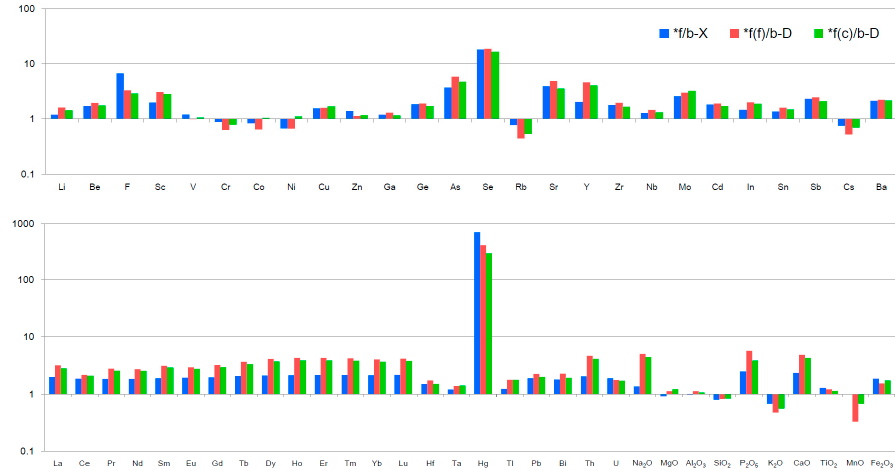
Figure 8. Average ratios of element concentrations in the fly ash vs. bottom ash from the Xilaifeng (X) and Damo (D) power plants.